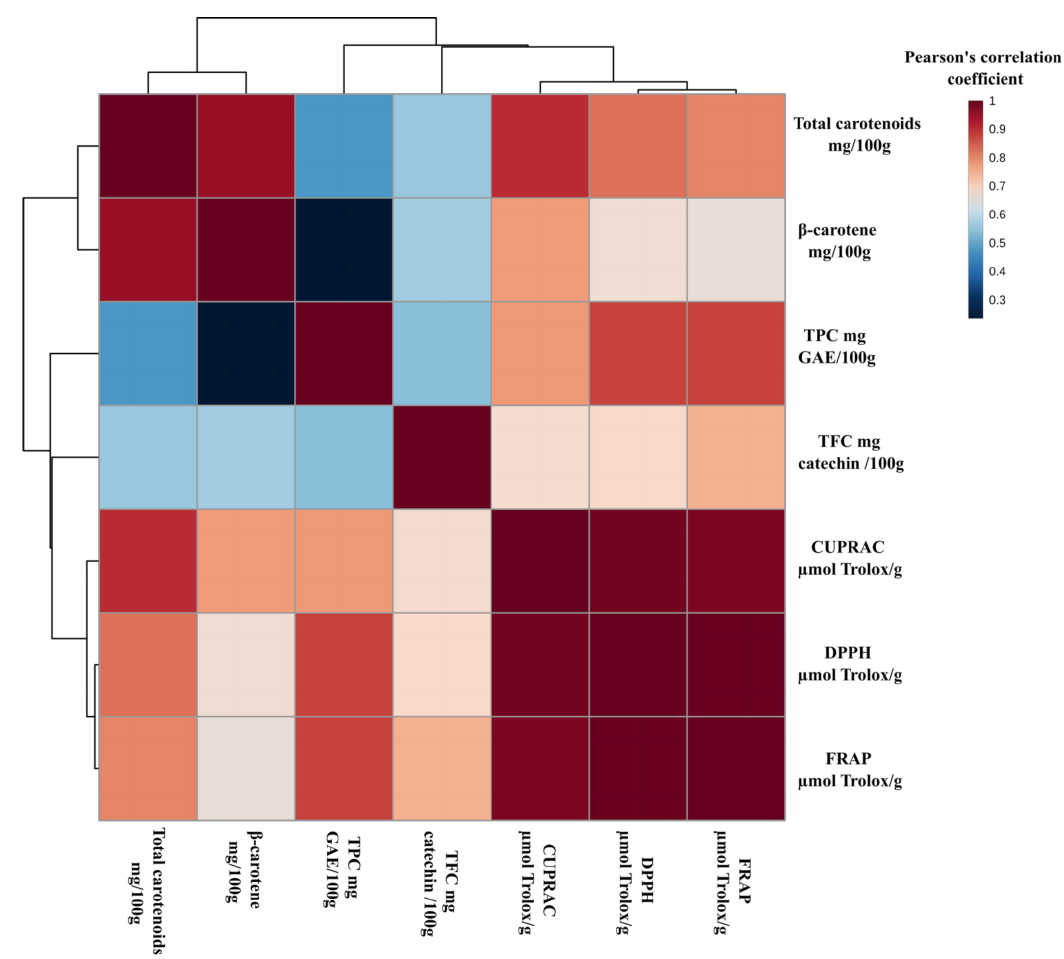
Figure 5. A heat map depicting Pearson’s correlation coefficients between TPC, TFC, CUPRAC, DPPH, FRAP, total carotenoids, and β -carotene. TPC—total phenolics content (mg GAE/100 g); TFC—total flavonoids content (mg CE/100 g); CUPRAC—cupric ion antioxidant reducing capacity ( µ mol TE/g); FRAP—ferric reducing antioxidant power ( µ mol TE/g); DPPH—2,2-diphenyl-1-picrylhydrazyl ( µ mol TE/g); GAE—gallic acid equivalents; CE—catechin equivalent; TE— Trolox